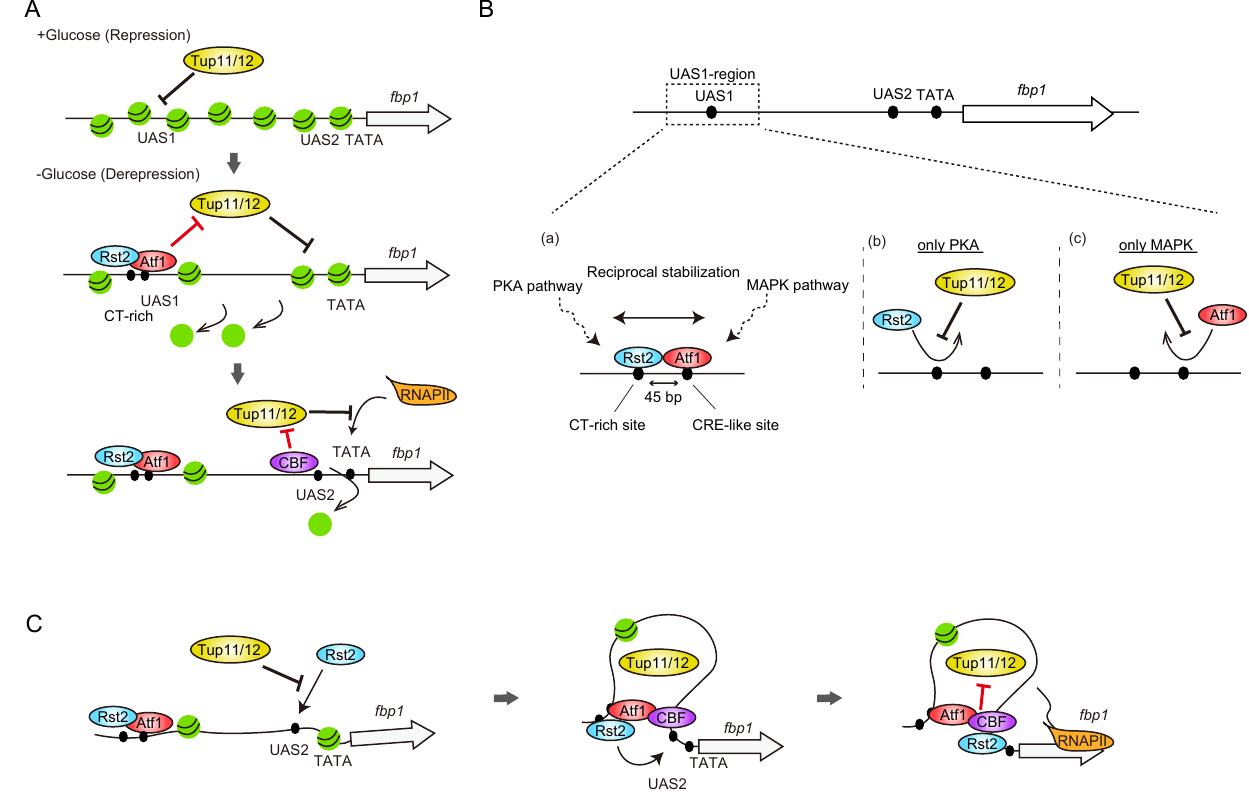
Figure 5. Tup11/12 mediated multi-layered repression and antagonization system for stress specific induction of fbp1 transcription. ( A ) Tup11/12 mediated regulations on the chromatin configurations. In glucose rich conditions, Tup11/12 repress the chromatin remodeling at UAS1-UAS2 region.